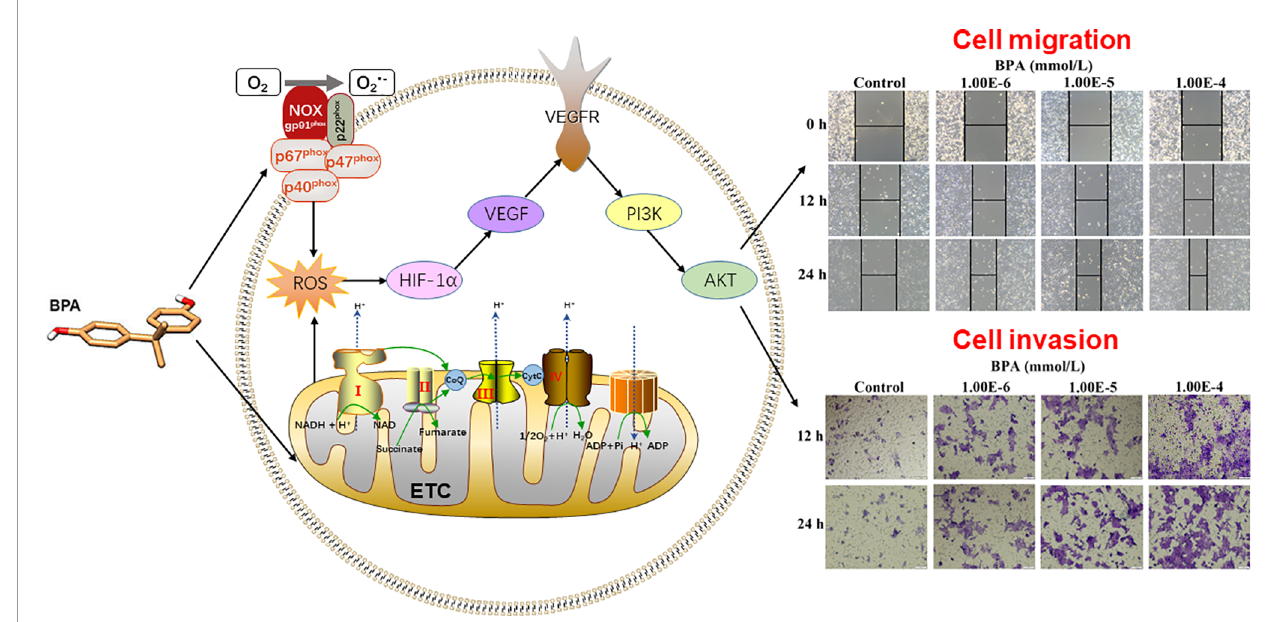
FIGURE 7 | Graphical